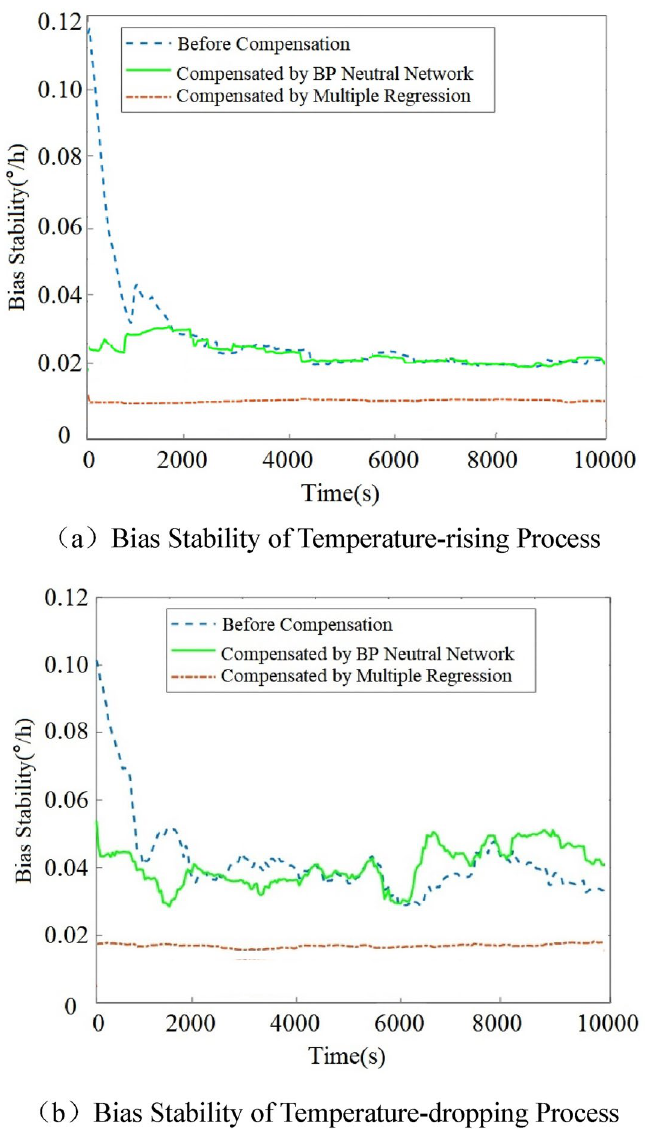
Figure 10. Bias stability of HRG before and after